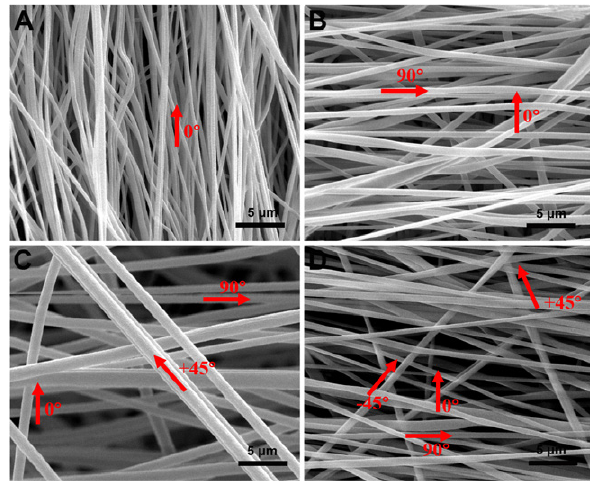
Figure 6: SEM images of PAN nanofiber membranes with different structures; A) 0 ∘ B) 0 ∘ /90 ∘ C) 0 ∘ /90 ∘ /+45 ∘ D) 0 ∘ /90 ∘ /+45 ∘ / − 45 ∘